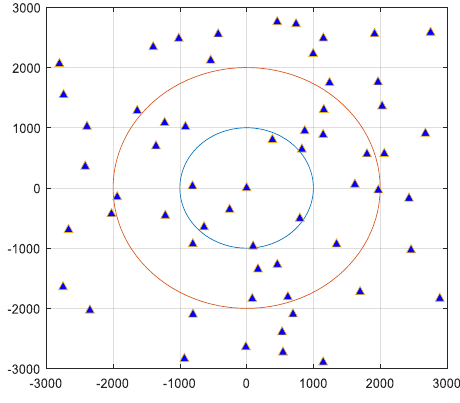
Figure 4. Simulation environment. Table 1. Simulation